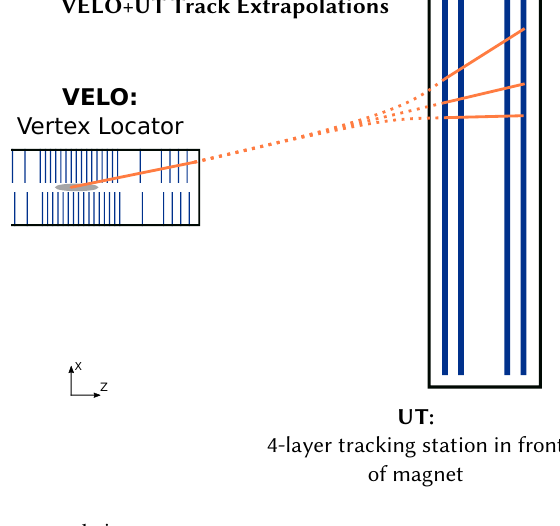
Figure 2. UT tracks